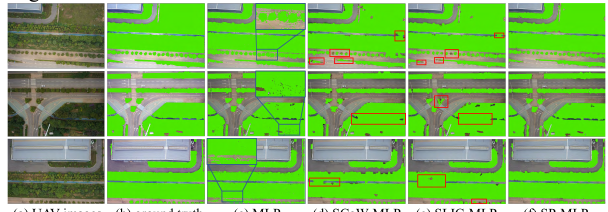
Figure 6. UAV image vegetation detection map.